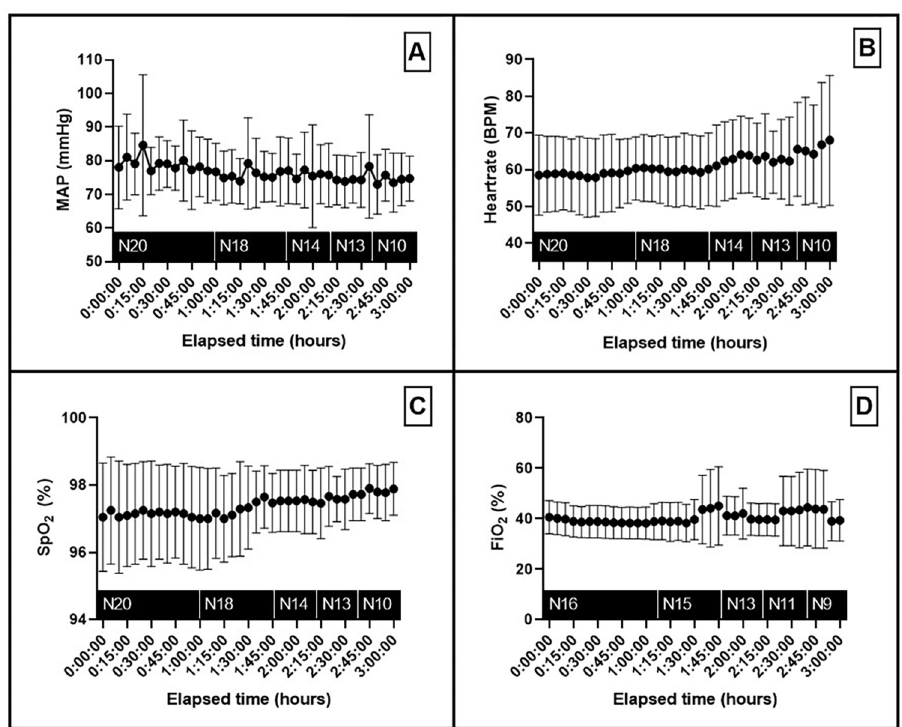
Fig 2. Overview of the hemodynamics parameters of the included patients during neurosurgery. A. Mean Arterial Pressure B. Heart rate. C. Peripheral oxygen saturation. D. Fraction of inspired oxygen. Data presented as mean (dot) and ± standard deviation. N; number of patients, MAP; mean arterial pressure, SpO2; peripheral oxygen saturation, FiO 2 ; fraction of inspired